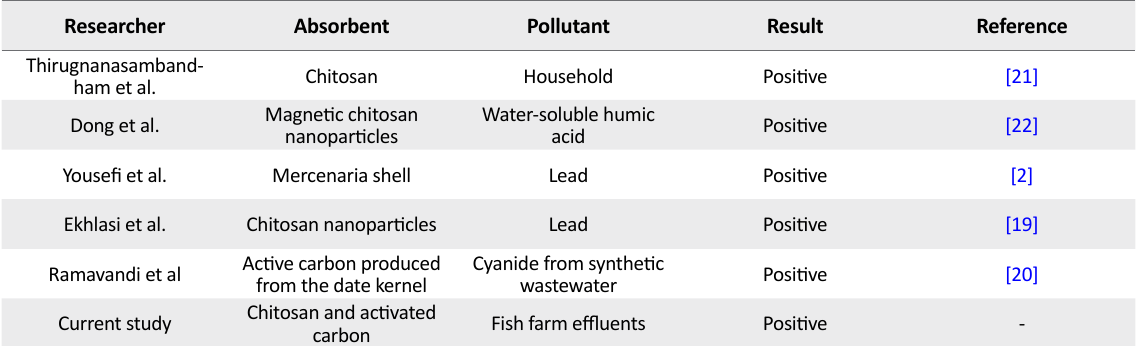
Table 6. Comparison of the similar studies on effluent absorbent